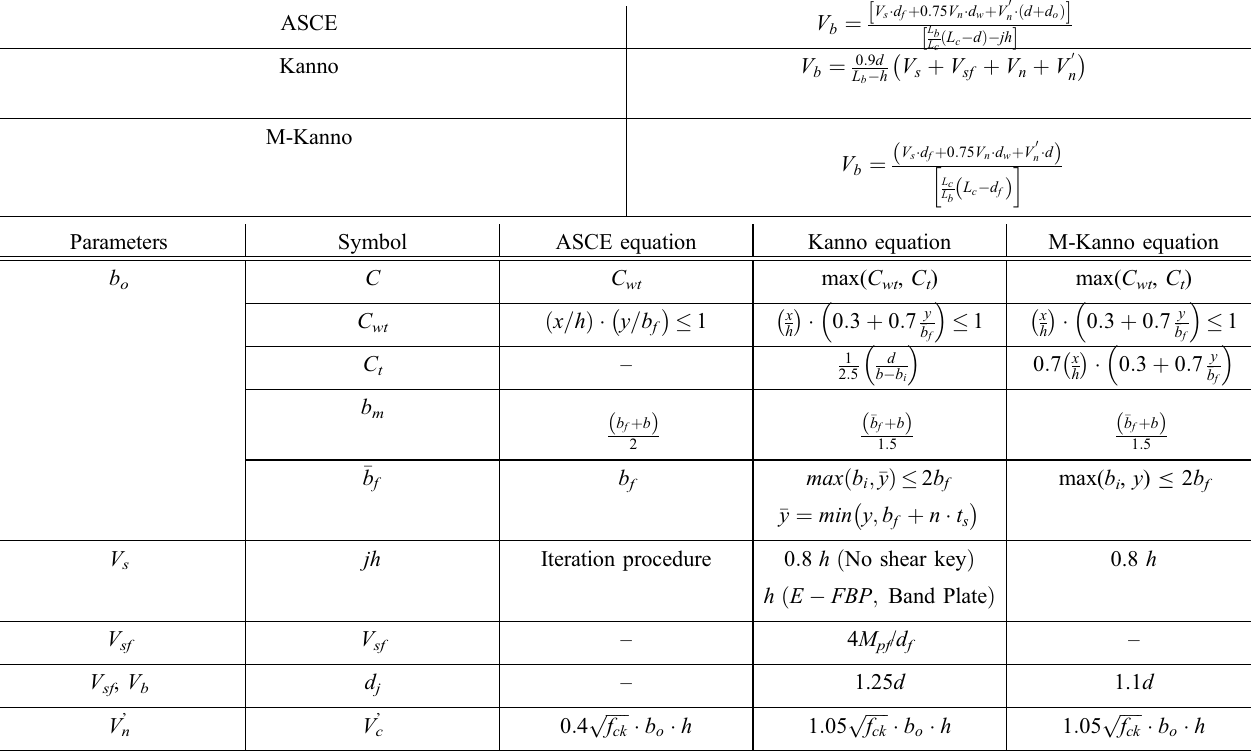
C Mobilization coefficient, C wt Mobilization coefficient for shear keys, C t Mobilization coefficient for transverse beam, (cid:2) b f Modified beam width, b m Maximum effective connection width, jh Effective steel beam web panel width, M pf Flange plastic moment, d j Effective connection height, d f Flange length, d o Reinforcing element thickness, L b Connection beam length, L c Connection column length, ASCE American Society of Civil